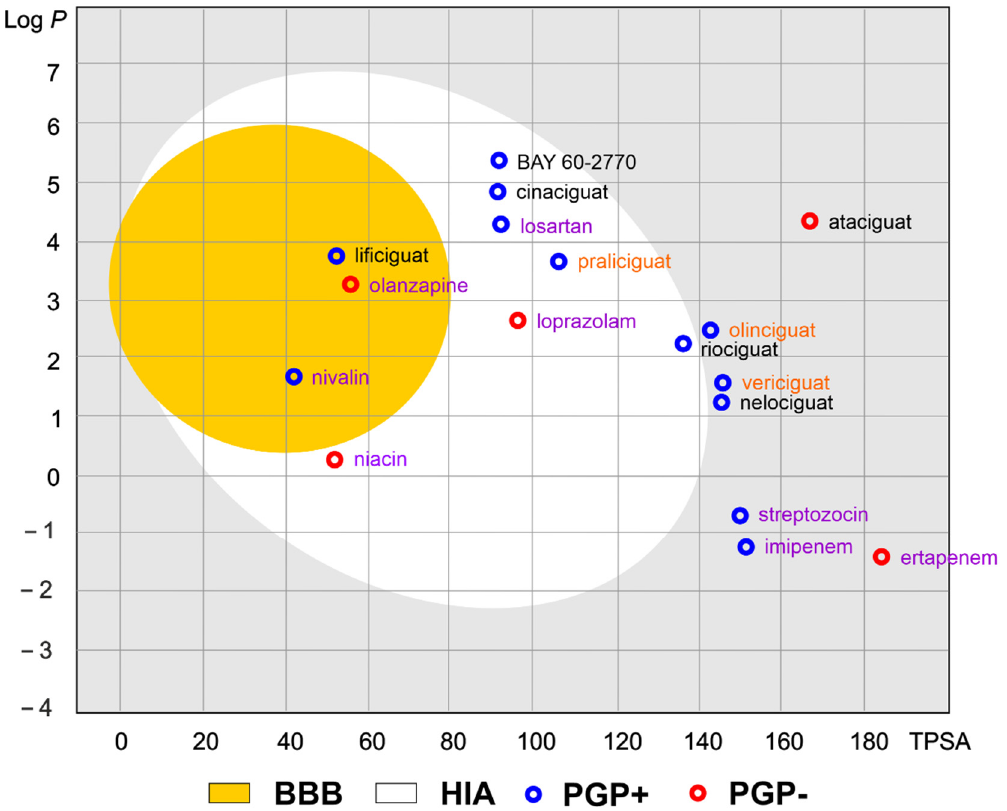
Figure 4. The Brain Or IntestinaL EstimatED (BOILED-Egg) graph compared sGC and selected commonly use drugs. The colored areas represent the optimal prediction range (above 93%) of penetration for brain (BBB, yellow) and gastrointestinal tract (HIA, white). The gray color indicates the area where penetration into the brain and gastrointestinal tract may occur but its probability is below the optimal value. The molecule predicted to be evaluated from the central nervous system by the P-glycoprotein (blue dots) or not (red dots). The compounds names are indicated in the different font colors, i.e., black corresponds to sGC stimulators, orange corresponds to sGC activators, and purple corresponds to selected drugs.